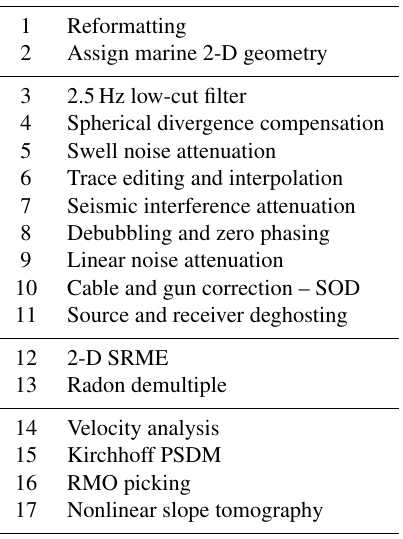
Table 1. Processing sequence of SFJ MCS